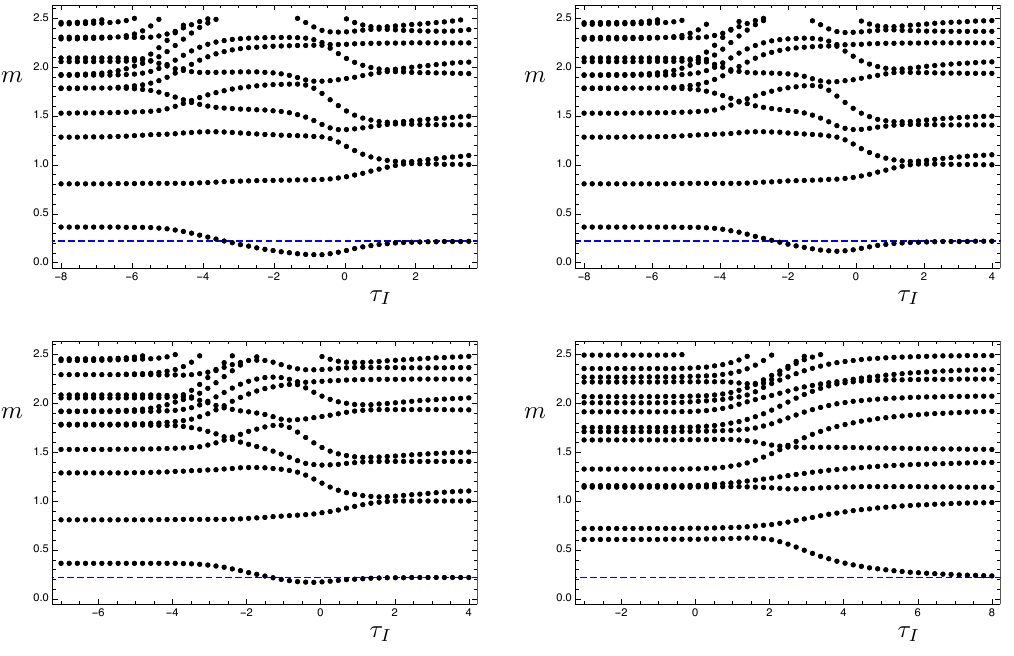
Figure 7 . Mass spectrum m of spin-0 states as a function of the IR cuto(cid:11) (cid:28) I , for a few backgrounds with di(cid:11)erent values of (cid:28) . The top-left panel has (cid:28) = (cid:0) 4, the top-right panel has (cid:28) = (cid:0) 3, the (cid:3) (cid:3) (cid:3) bottom-left panel has (cid:28) = (cid:0) 2, and the bottom-right panel has (cid:28) = 3. The dashed blue line (cid:3) (cid:3) corresponds to the mass of the lightest state in the hyperscaling violating toy model of appendix D. All the plots are normalized to the mass of the lightest spin-2